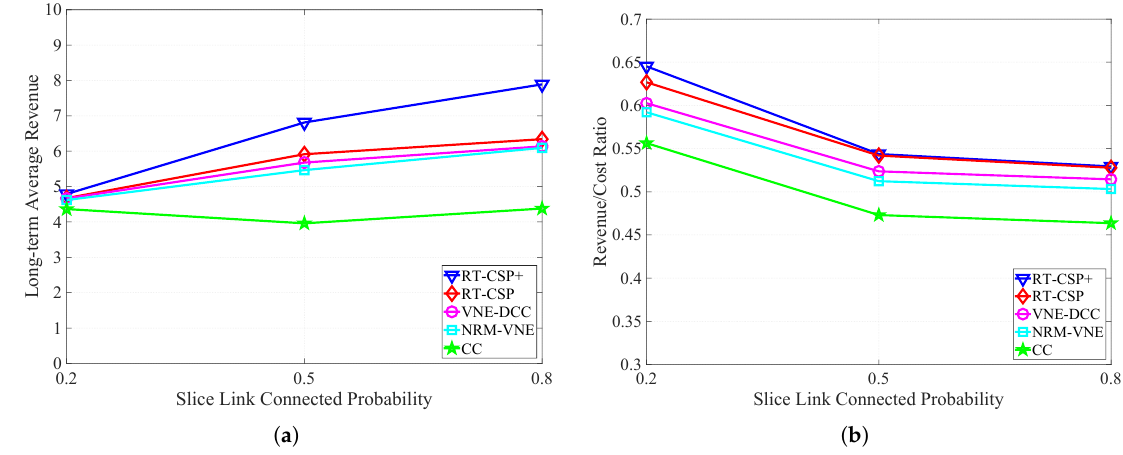
Figure 5. ( a ) Long-term average slice provisioning revenue in the different slice link connected probability scenario; and ( b ) slice provisioning revenue-to-cost ratio in the different slice link connected probability